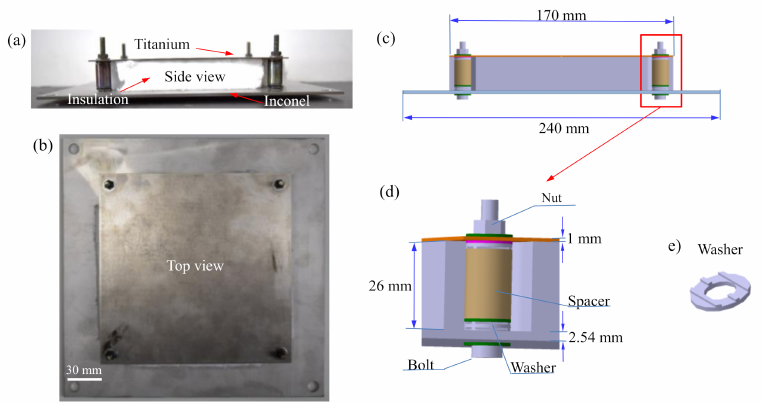
Figure 2. A metallic TPS panel for dynamic testing: ( a ) side view and ( b ) top view of the metallic TPS panel, ( c ) 3D model of the metallic TPS panel, ( d ) the bolted joint, ( e ) washer. Table 1. Experimental cases for dynamic characteristics and damage states of the TPS panel. Components Load-Carrying